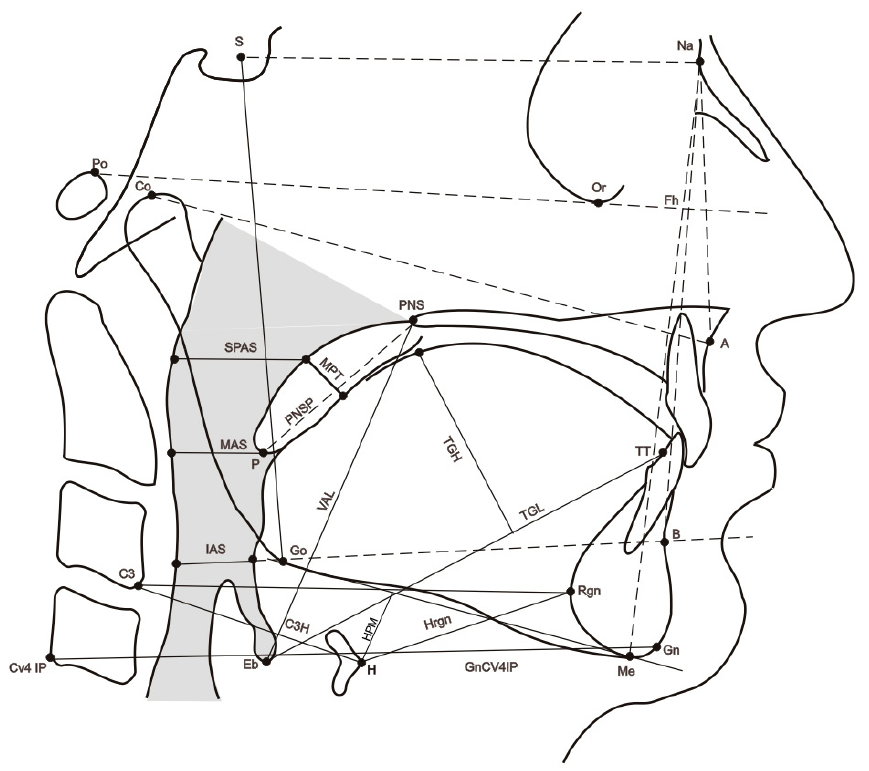
Figure 1. Sagittal cephalometric view showing the reference parameters (points, planes, angles, and Cartesian coordinates) used in the study. Cephalometric points. Na: nasion, most anterior point of the fronto-nasal suture; S: sella, geometric centre of the sella turcica; Eb: base of the epiglottis; H: most anterior point of the body of the hyoid bone; TT: tip of the tongue; RGn: most posterior point of mandibular symphysis at the level of the mid-sagittal plane; CV4IP: most inferior point of the C4; Co: most anterior and superior point of the mandibular condyle; Gn: most anterior and inferior point of the mandible at the level of the mid-sagittal plane of the symphysis; B: most posterior point of the anterior concavity of the mandibular symphysis; Go: most posteroinferior point of the mandible; A: most posterior point of the anterior concavity of the maxillary bone. Me: inferior most point of mandibular symphysis. Po: most superior point of the external auditory canal. Table 1. Cephalometric variables and their abbreviations.